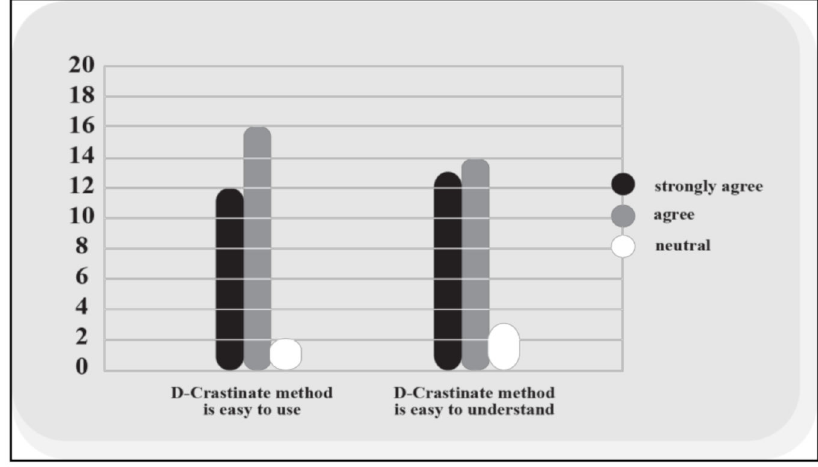
Figure 1. Clarity and ease of